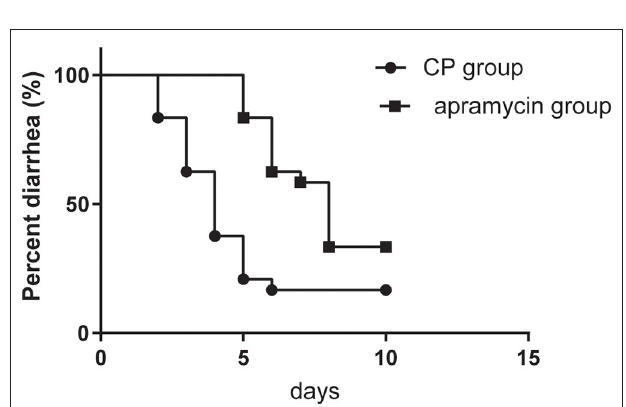
FIGURE 3 | Kaplan-Meier survival curve describing the time needed for recovery after the onset of diarrhea at the 123 diarrheal calves in the group of calves receiving CP and at the 123 diarrheic calves receiving apramycin